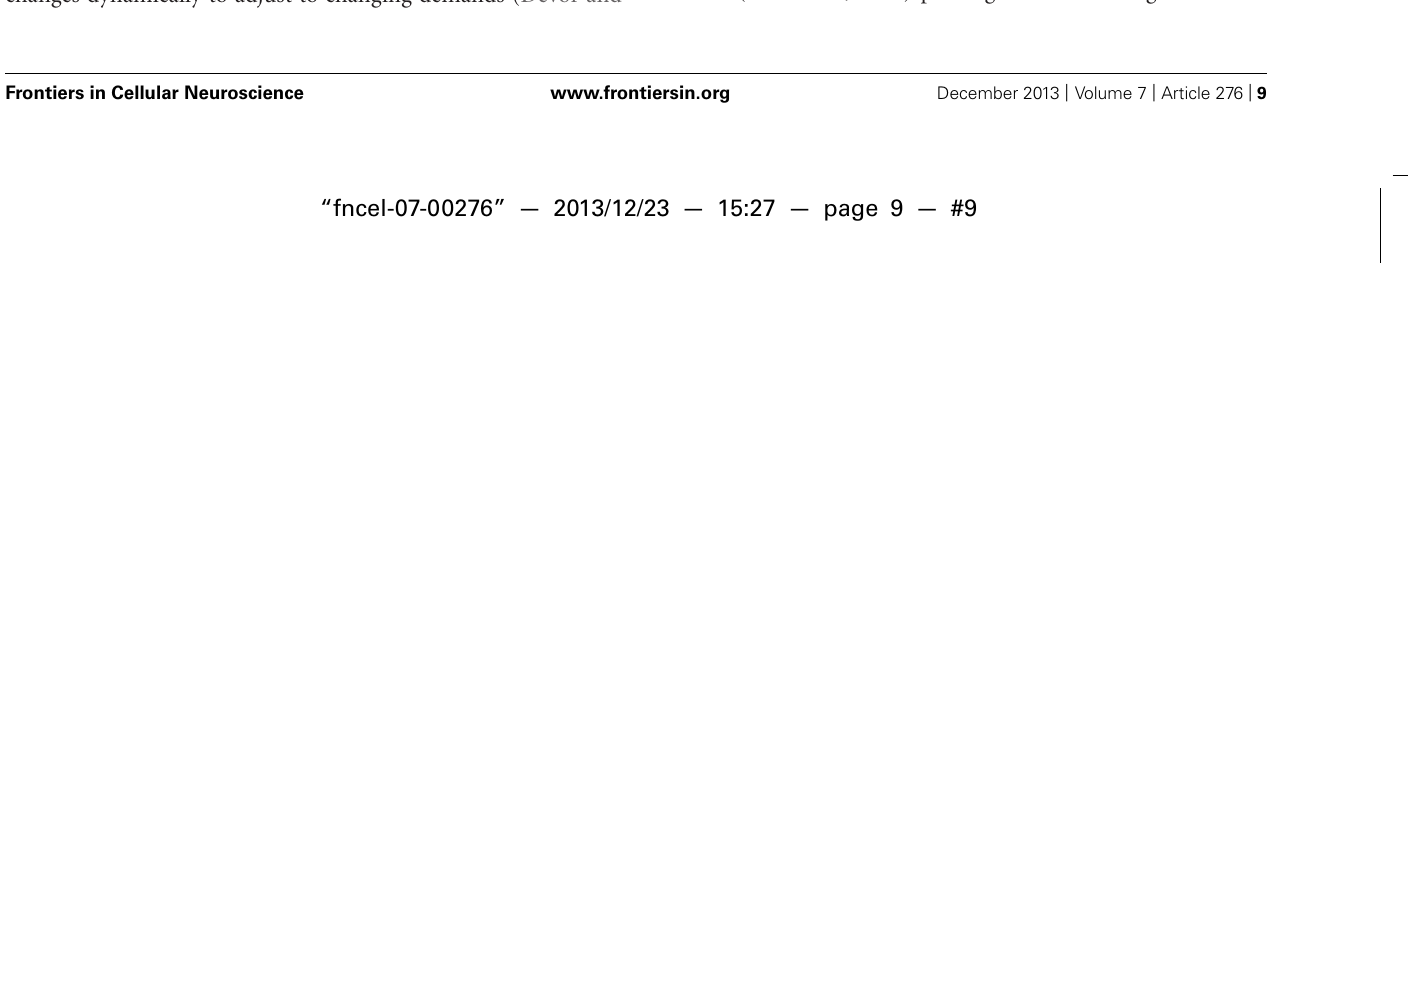
FIGURE 7 | Integration of sensory information in the time domain by plateau potential generating neurons. (A) A depolarizing current pulse produced incrementing firing frequency followed by a depolarizing after-potential. (B) Windup of the response to repeated current pulses (a) as well as to repeated